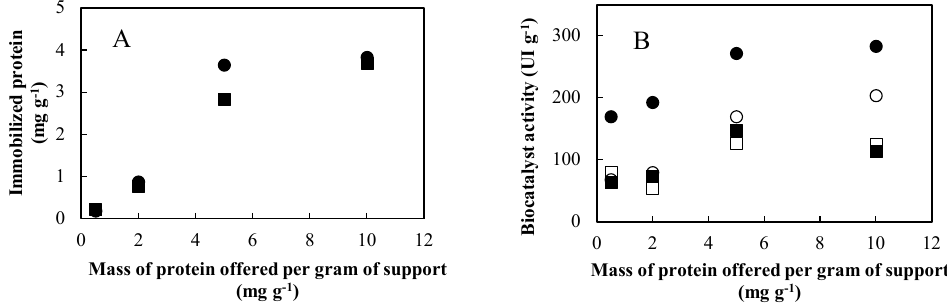
Figure 3. Maximum loading capacity of ● BGA and ∎ OGA in terms of ( A ) mass of protein immo- bilized and ( B ) biocatalyst activity. Open and closed symbols in B represent the activity of p NPG and p NPR, respectively.